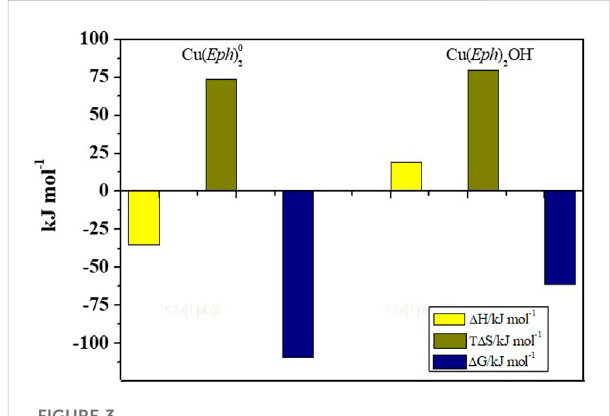
FIGURE 2 UV-Vis spectra recorded at some pH values for the Cu 2+ / Eph − system at I = 0.156 mol dm − 3 in NaCl (aq) , T = 298.15K, c Cu2+ = 0.0566 mmol dm − 3 e c Eph- =0.0622 mmol dm − 3 .1.pH=3.07;2.pH= 5.26; 3. pH = 6.48; 4. pH = 7.49; 5. pH = 10.73.